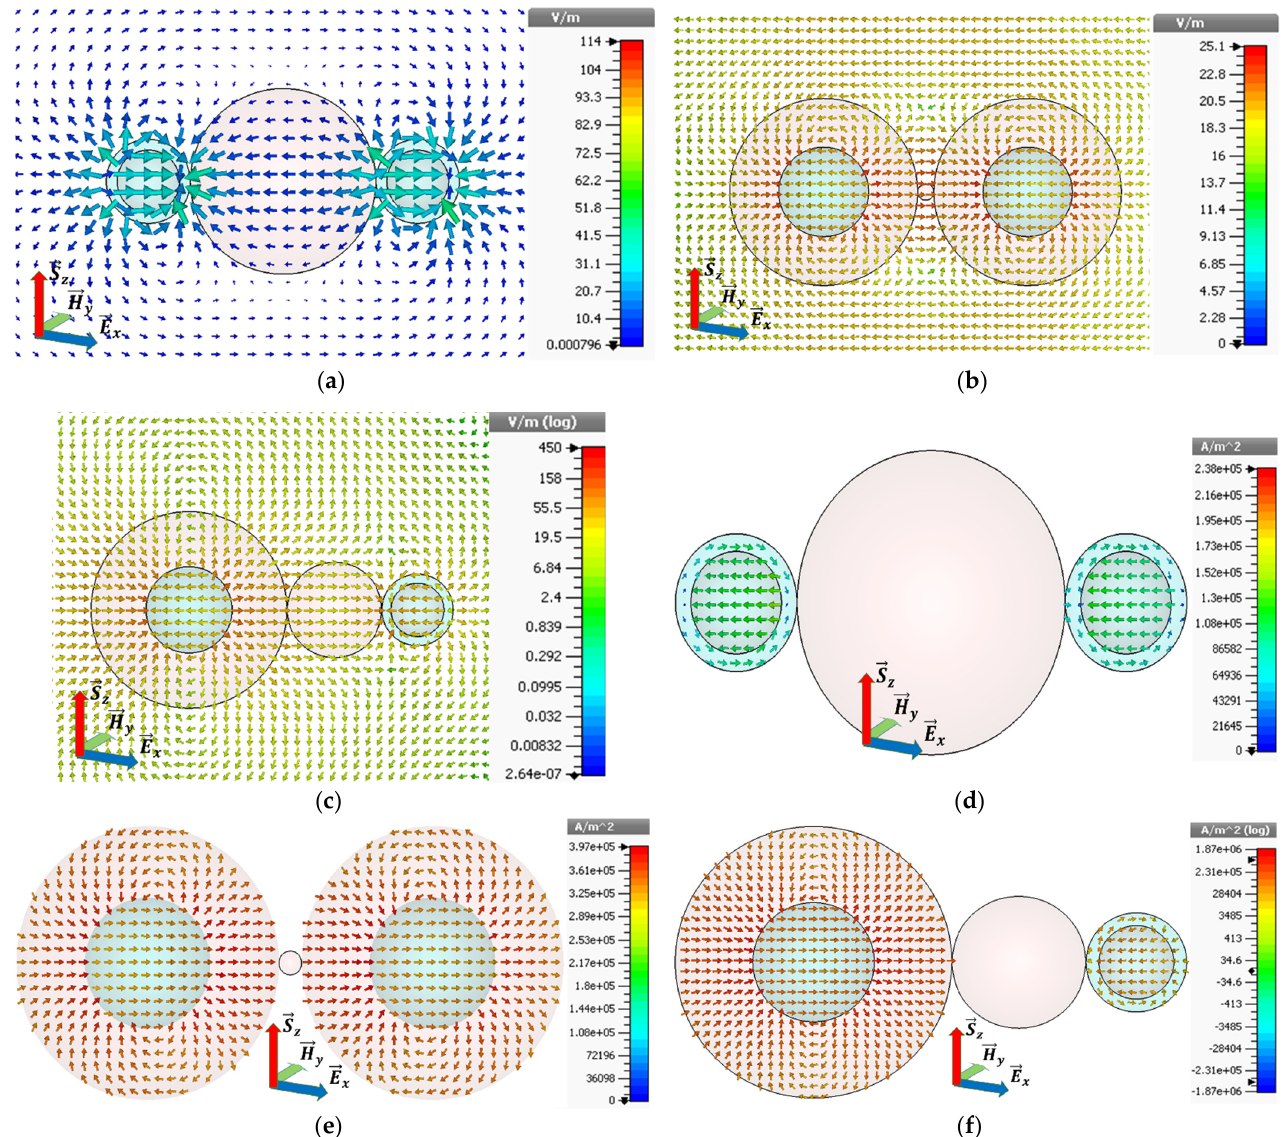
Figure 5. The electric fields of ( a ) configuration I ( b ) configuration II and ( c ) configuration III, respectively, at their respective resonance frequencies. Similarly, ( d ) shows electric current of configuration I, ( e ) shows configuration II and ( f ) shows configuration III, respectively, at their respective resonance frequencies.